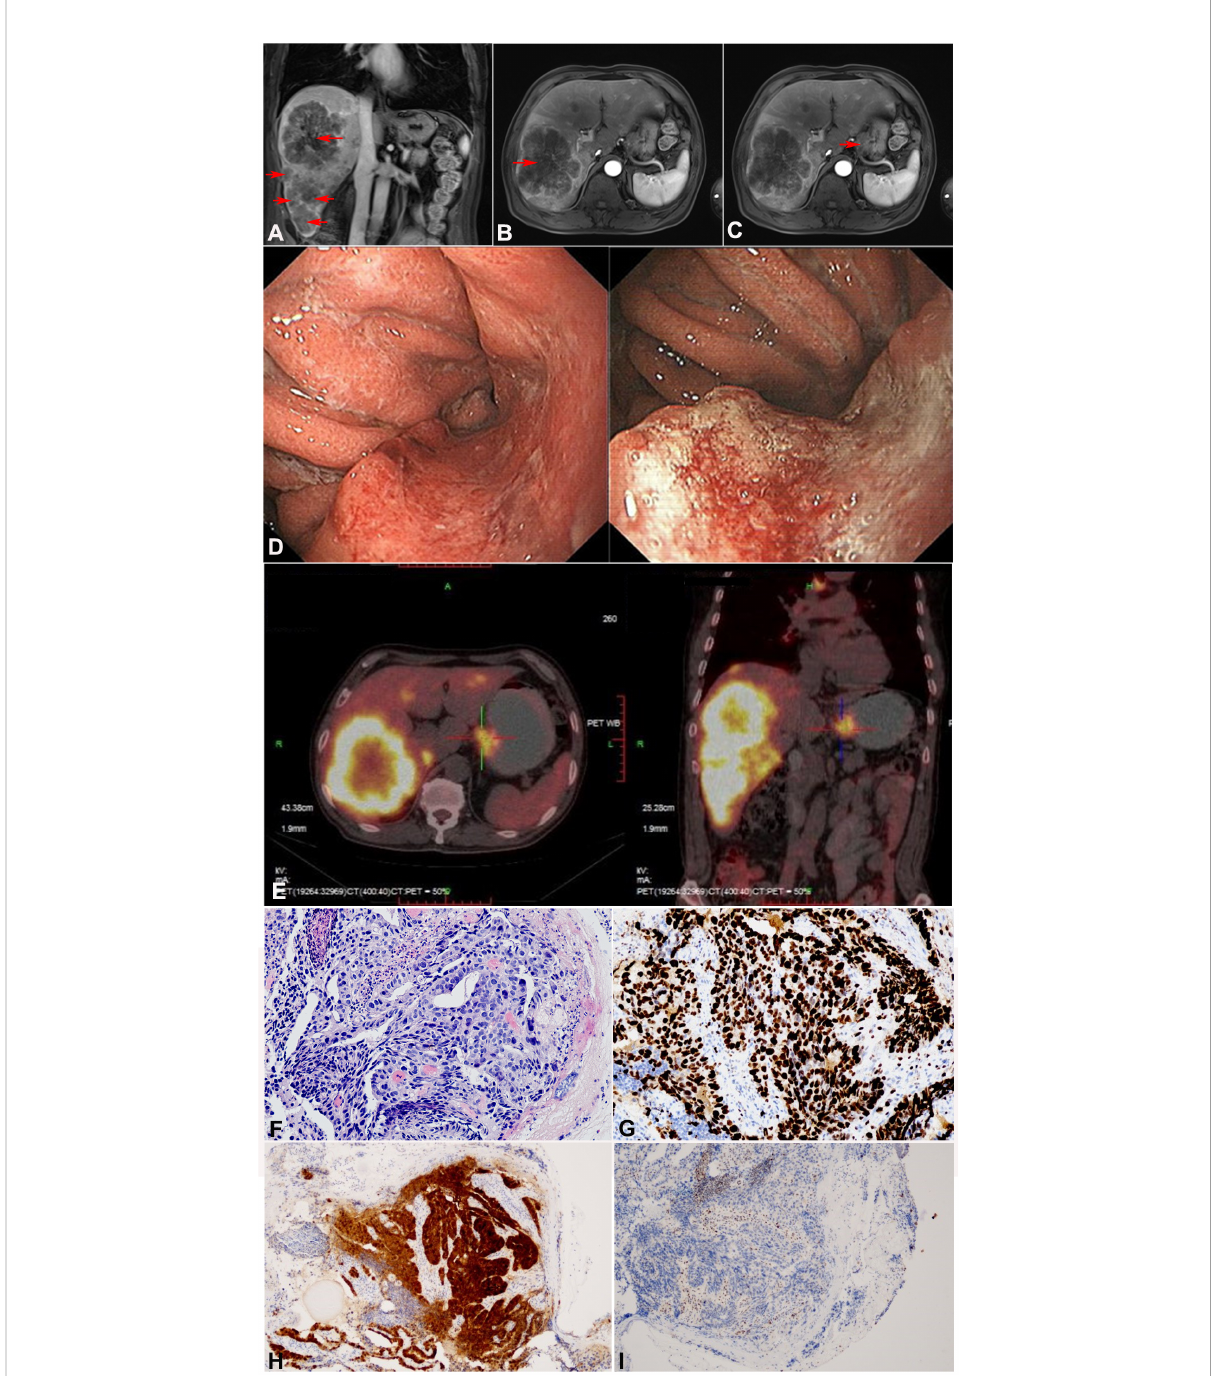
FIGURE 1 Imaging and pathological examination of the patient before treatment (tumor marked in red arrow). (A – C) Abdominal MRI revealed a soft tissue mass in the gastric cardia and multiple scattered nodules in the liver, (A) Coronal imaging of the lesion on liver, (B) Sagittal imaging of the lesion on liver, (C) Sagittal imaging of the lesion on gastric cardia. (D) Upper gastrointestinal endoscopy fi ndings before treatment. The posterior wall of the cardia showed surrounding eminence and central ulcerative lesions with an area of 1.8 × 1.8 cm. (E) PET-CT showed uneven thickening of the gastric wall in the cardia area, as well as multiple nodules in the liver. (F – I) Pathological examination of gastric biopsy specimen con fi rmed moderately differentiated adenocarcinoma. (F) H&E, × 200. (G) Ki67, × 200. (H) P16, ×100. (I) P53, ×